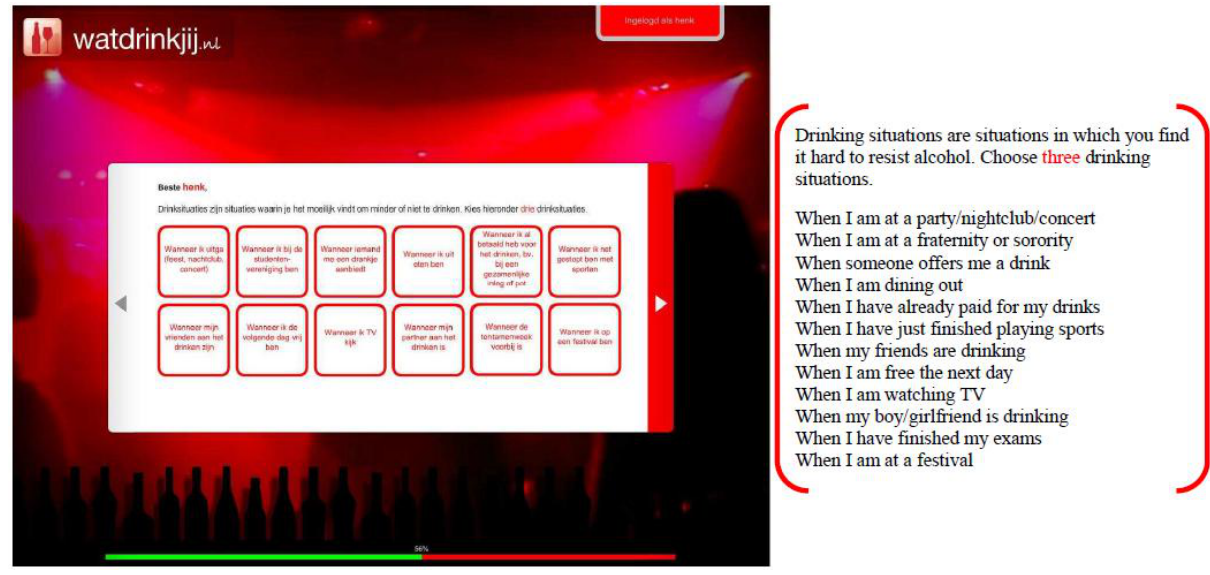
Figure 4. Screenshot and English translation of the overview of drinking situations on the What Do You Drink